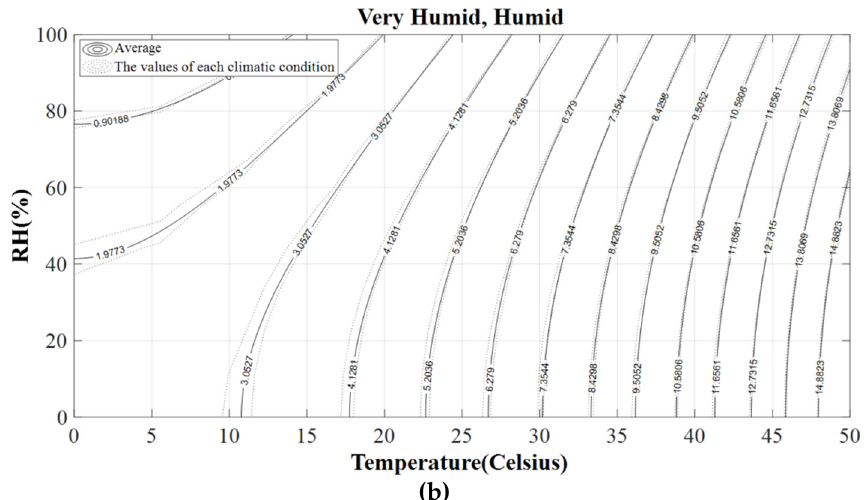
Figure 7. Graphs of the six best experimental relationships (quadratic relationships) simulating pan evaporation with the two-parameter input combination, under ( a ) dry, semi-dry, Mediterranean, and semi-humid climatic conditions and ( b ) humid and very humid climatic conditions.